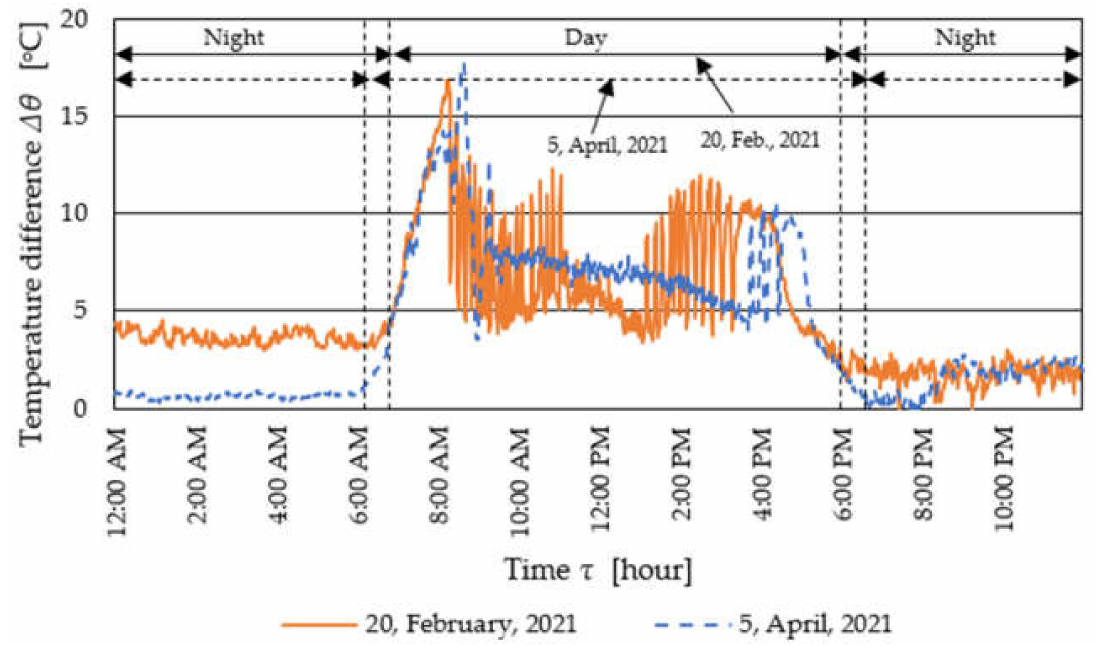
Figure 9. The air temperature difference between the inside and outside on each day.